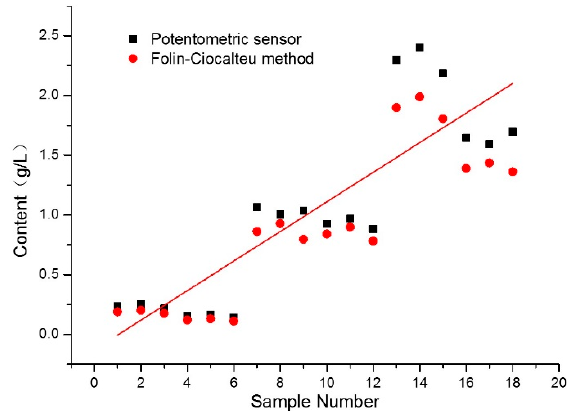
Figure 6. Correlation of total phenolic content in wine samples determined by potentiometric sensor and Folin–Ciocalteu method.